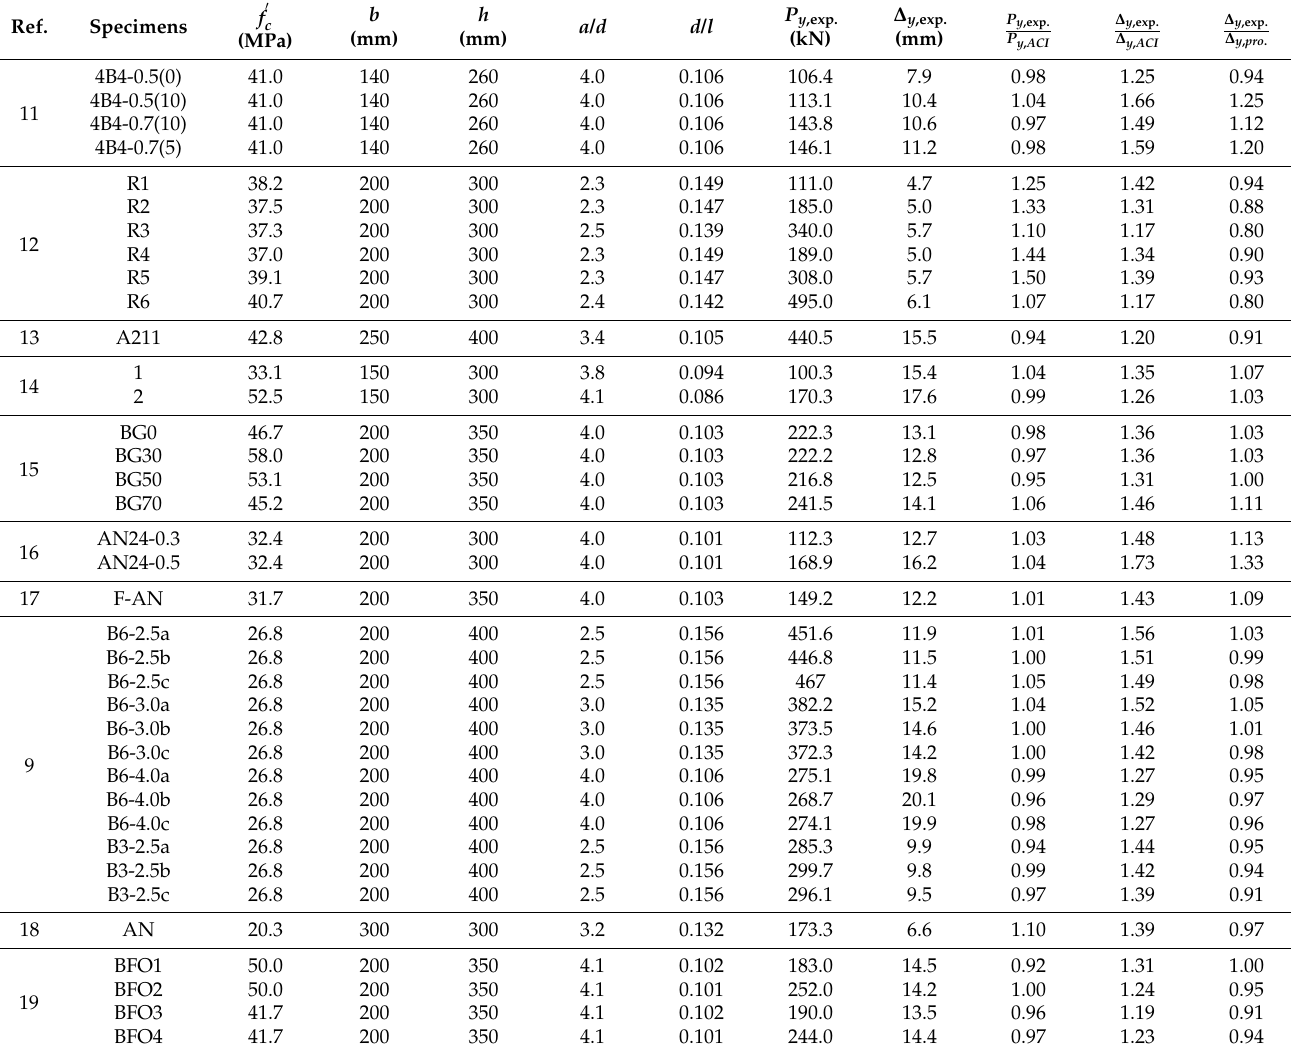
Table 3. Comparison of Observed and Predicted Results of Flexure-Critical RC Beams Reported in the Literature. Ref.